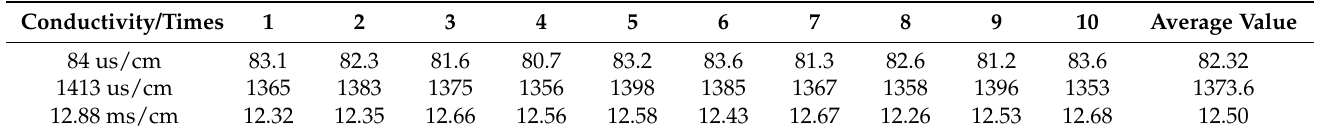
Table 1. Laboratory standard liquid conductivity comparison